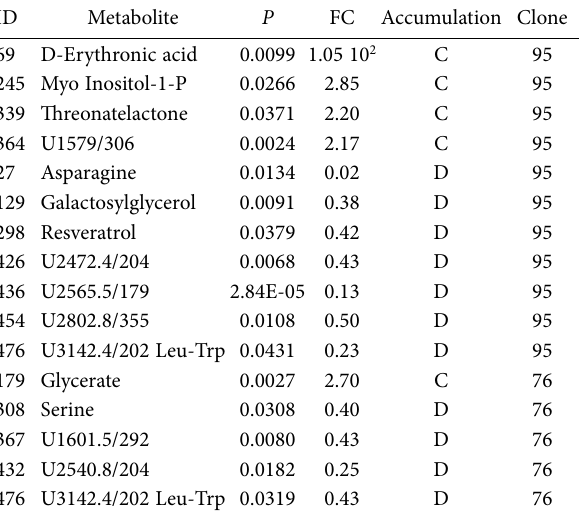
Table 3. Metabolite analyses . Significant metabolite ID numbers, names, values and respective accumulations of significant metabo- lites ( P < 0.05, fold change (FC) > 2) in grapevine leaf samples from Chardonnay grapevine clones 95 and 76. (C = greater accumulation in control leaf samples, D = greater accumulation in esca-affected leaf